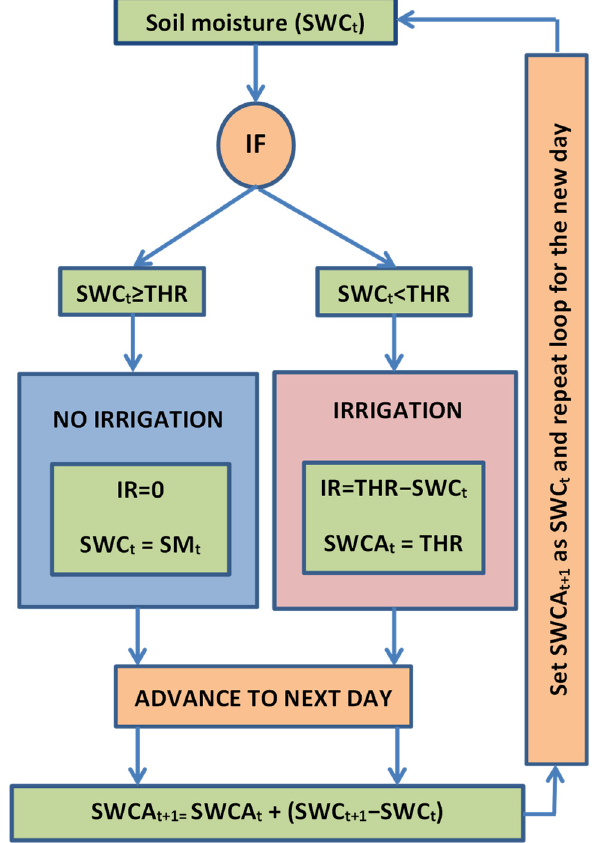
Figure 2. Calculation procedure for determining irrigation requirement (SWC t , measured SWC on day t; THR, SWC threshold for triggering irrigation; IR, irrigation requirement; SWCA t , adjusted SWC on day t; SWCA t+1 , adjusted water content on day t + 1; SWC t+1 , measured SWC on day t + 1).